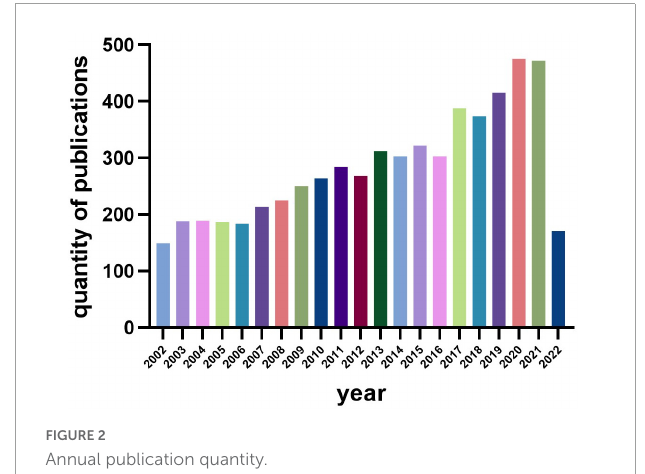
FIGURE2 Annual publication quantity.